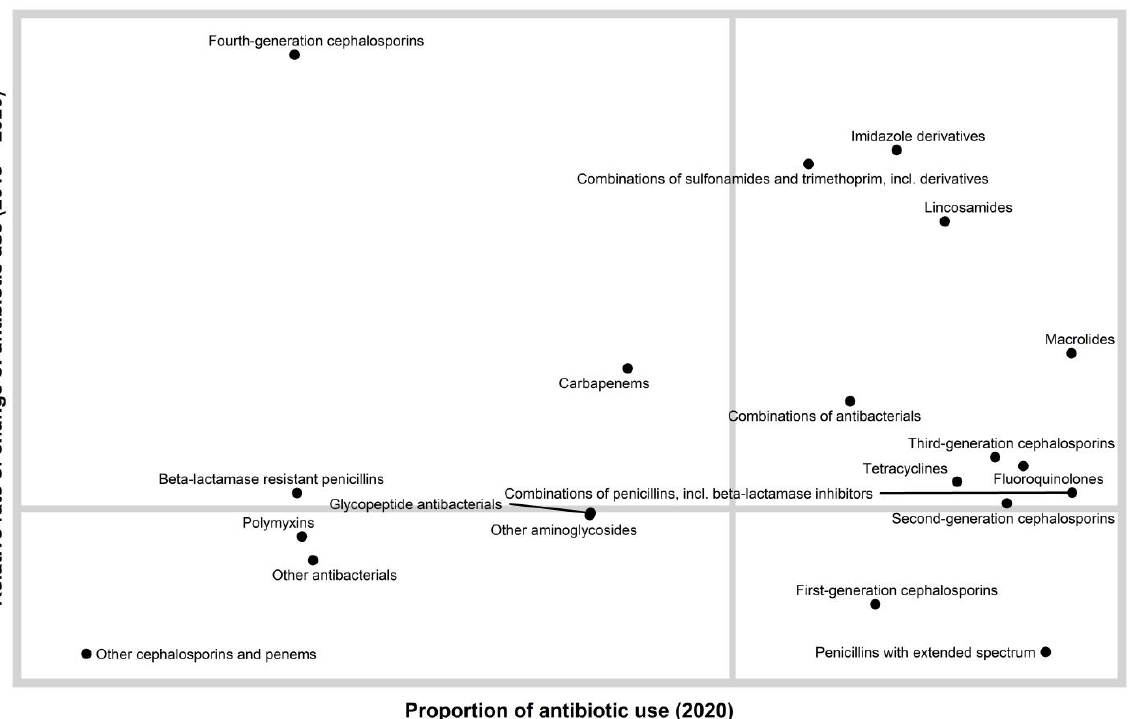
Figure 1. A quadrant chart showing the distribution of antibiotic classes according to rate of change of antibiotic use (2019–2020) and the proportion of antibiotic use in 2020. This chart enables a relative comparison of both antimicrobial levels and trends. We can consider the antimicrobials in the lower right quadrant as widely dispensed but at a lower rate than the previous year. We can consider the upper right quadrant as widely dispensed but at a higher rate than the previous year. The upper right quadrant contains antimicrobials that are candidates for further evaluation. Table 2. Percentage of total national antimicrobial consumption (DDDs) by WHO AWaRe cate- gory (Access/Watch/Reserve) for Jordan 2019 and 2020.